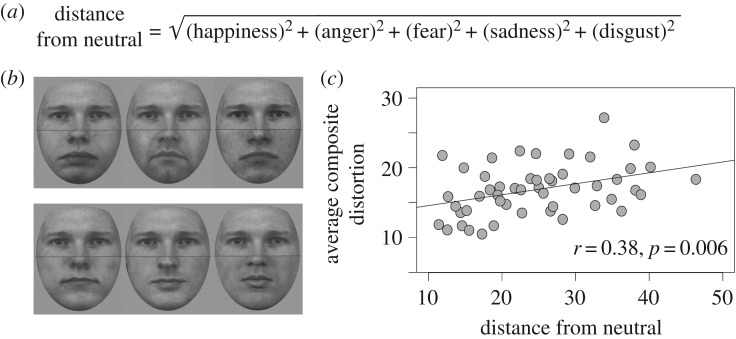
(a) To produce a single estimate of the perceived emotion present in each distractor, we computed its Euclidean distance in emotion space from the point of absolute neutrality. (b) Examples of facial composites used Experiment 2 constructed with distractors rated high (top) and low (bottom) in perceived emotion. Observers were required to rate the extent to which the lower face half distorted their percept of the upper face half. (c) The correlation between the average magnitude of composite distortion and the average distance of each distractor half from true neutral.